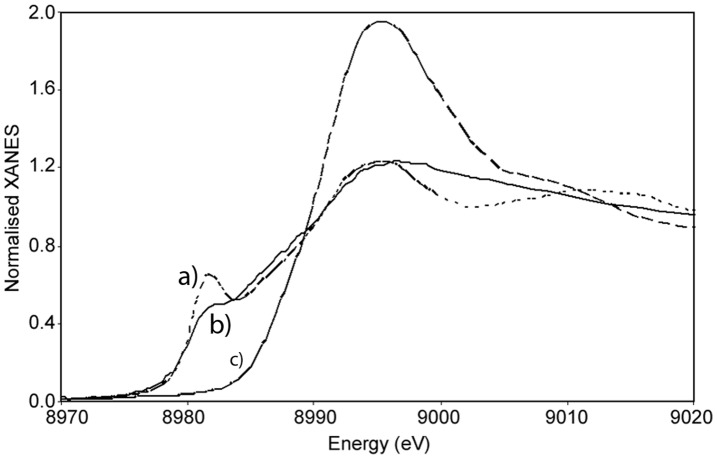
XAS analysis of MopE*.Normalised XANES of a) Cu(I) oxide (–), b) MopE* protein (–), and c) Cu(NH4)2(SO4)2⋅6H2O (Cu(II) tutton salt) (–).